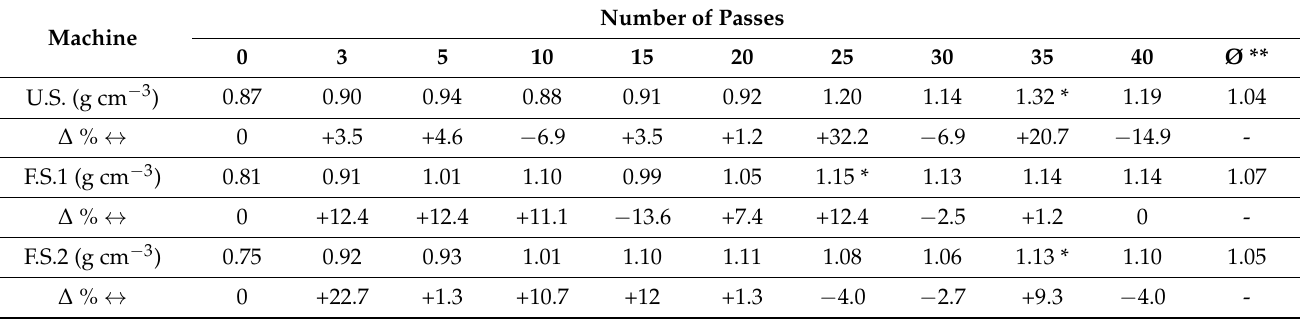
Table 4. Dry soil bulk density and the percentage increase between the particular number of ma- chine